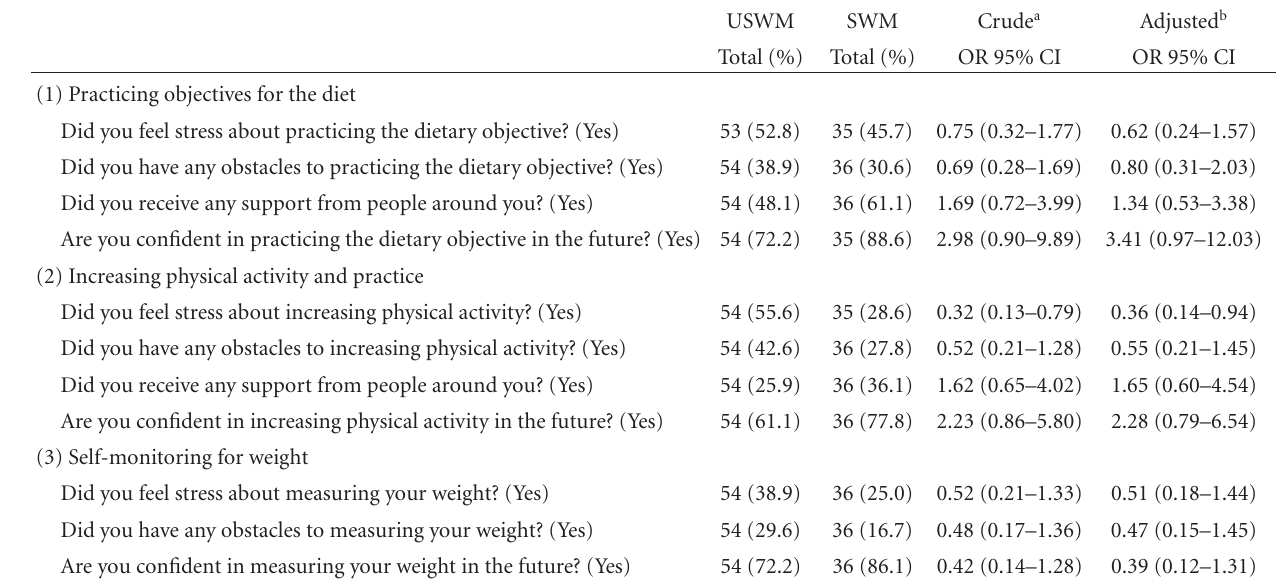
Table 3: Comparisons of participants’ stress, obstacles and support during weight loss program and confidence to continue weight control behaviors in the future between successful weight maintainers and unsuccessful weight